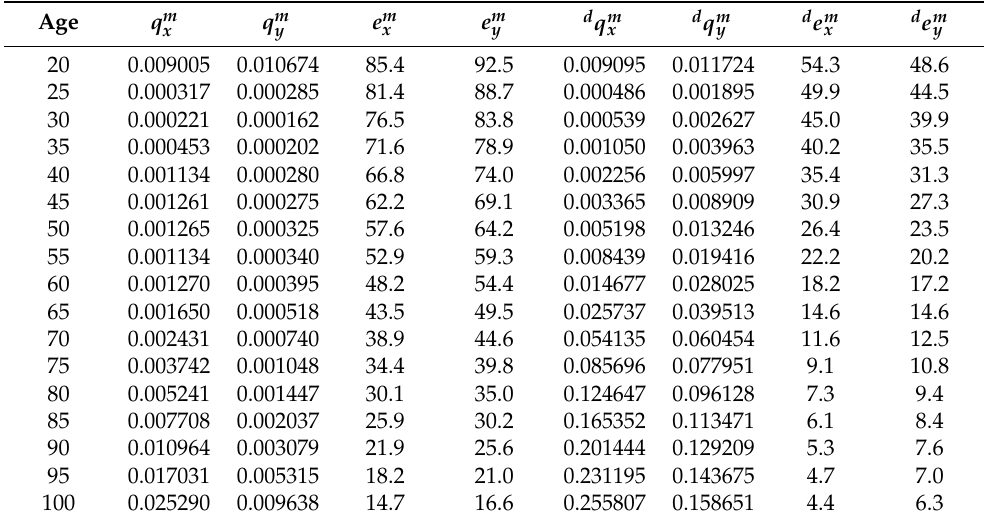
Table 3. Mortality rates and life expectancy of people born in 1970, values by sex and age. Source: Own work.